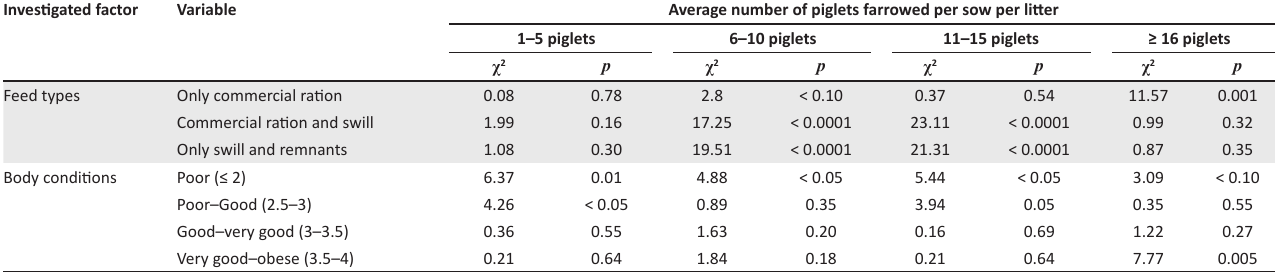
TABLE 5: Association between average number of piglets farrowed per sow per litter, types of feed used and body condition scores. Investigated factor Variable Average number of piglets farrowed per sow per